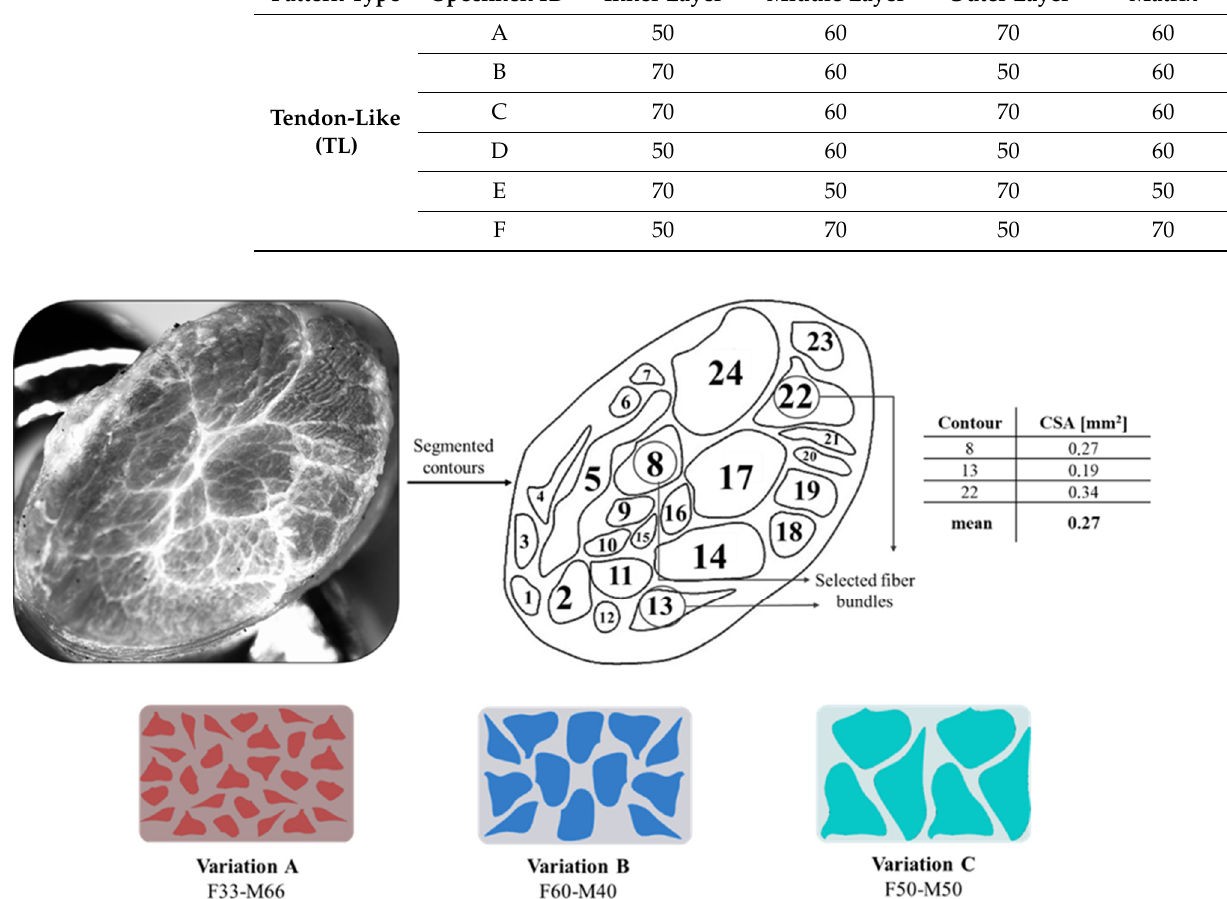
Figure 6. Tendon-Mimic (TM) pattern arrangement. The segmented contours of the equine tendon and cross-sectional areas are reported, as well as the percentage of area occupied by the fibers on the narrow cross-section of the specimen.